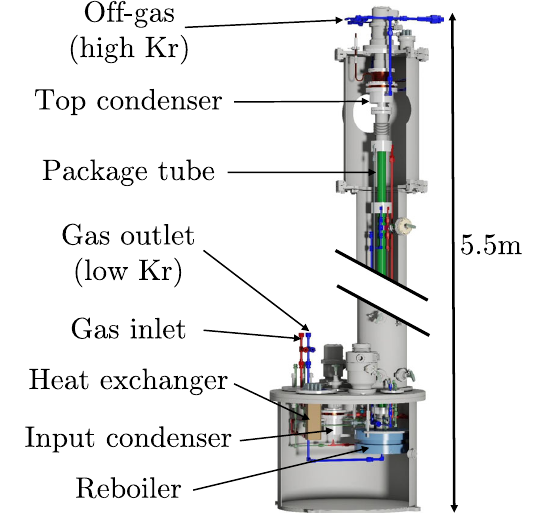
Fig. 11 The custom-designed XENON1T cryogenic distillation col- umn. The outer vessels for vacuum insulation and most of the column package material were omitted for